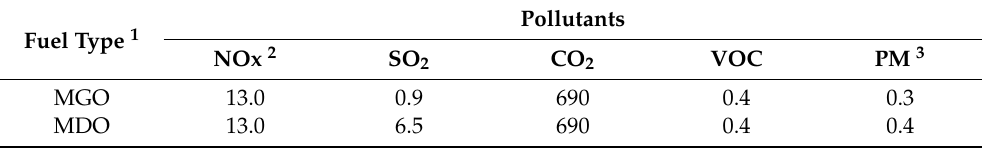
Table 1. Auxiliary engine emissions factors for pollutants by fuel type during hoteling [g/kWh].